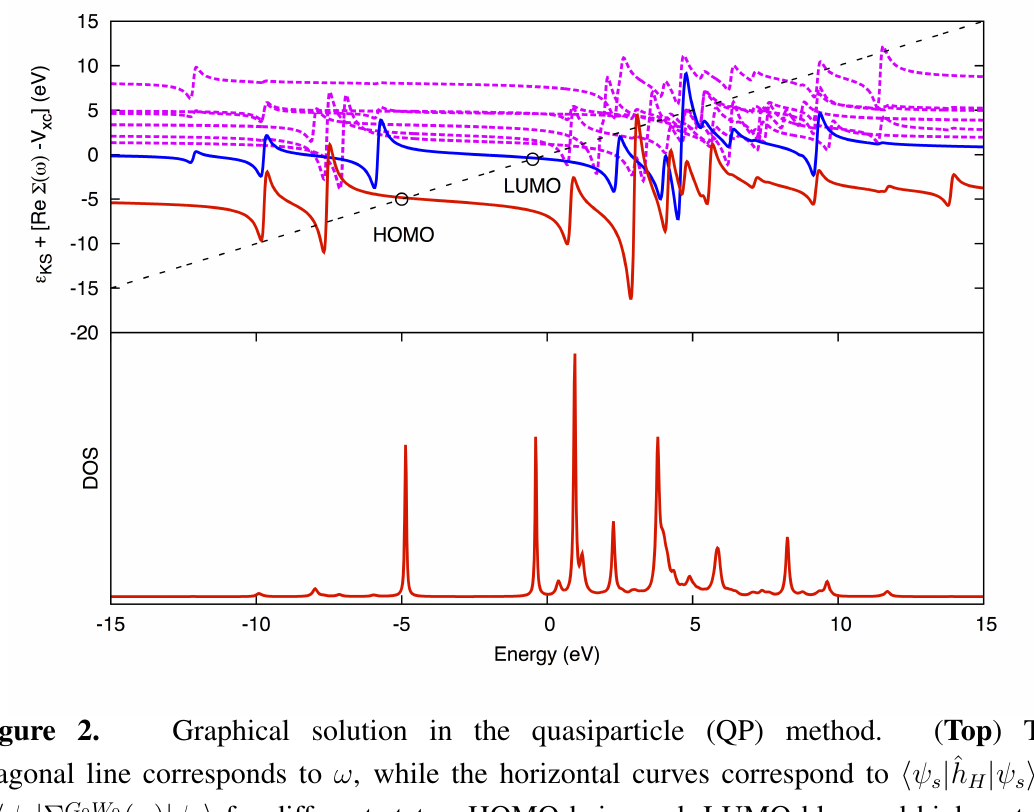
| ˆ h | ψ (cid:105) + s H s